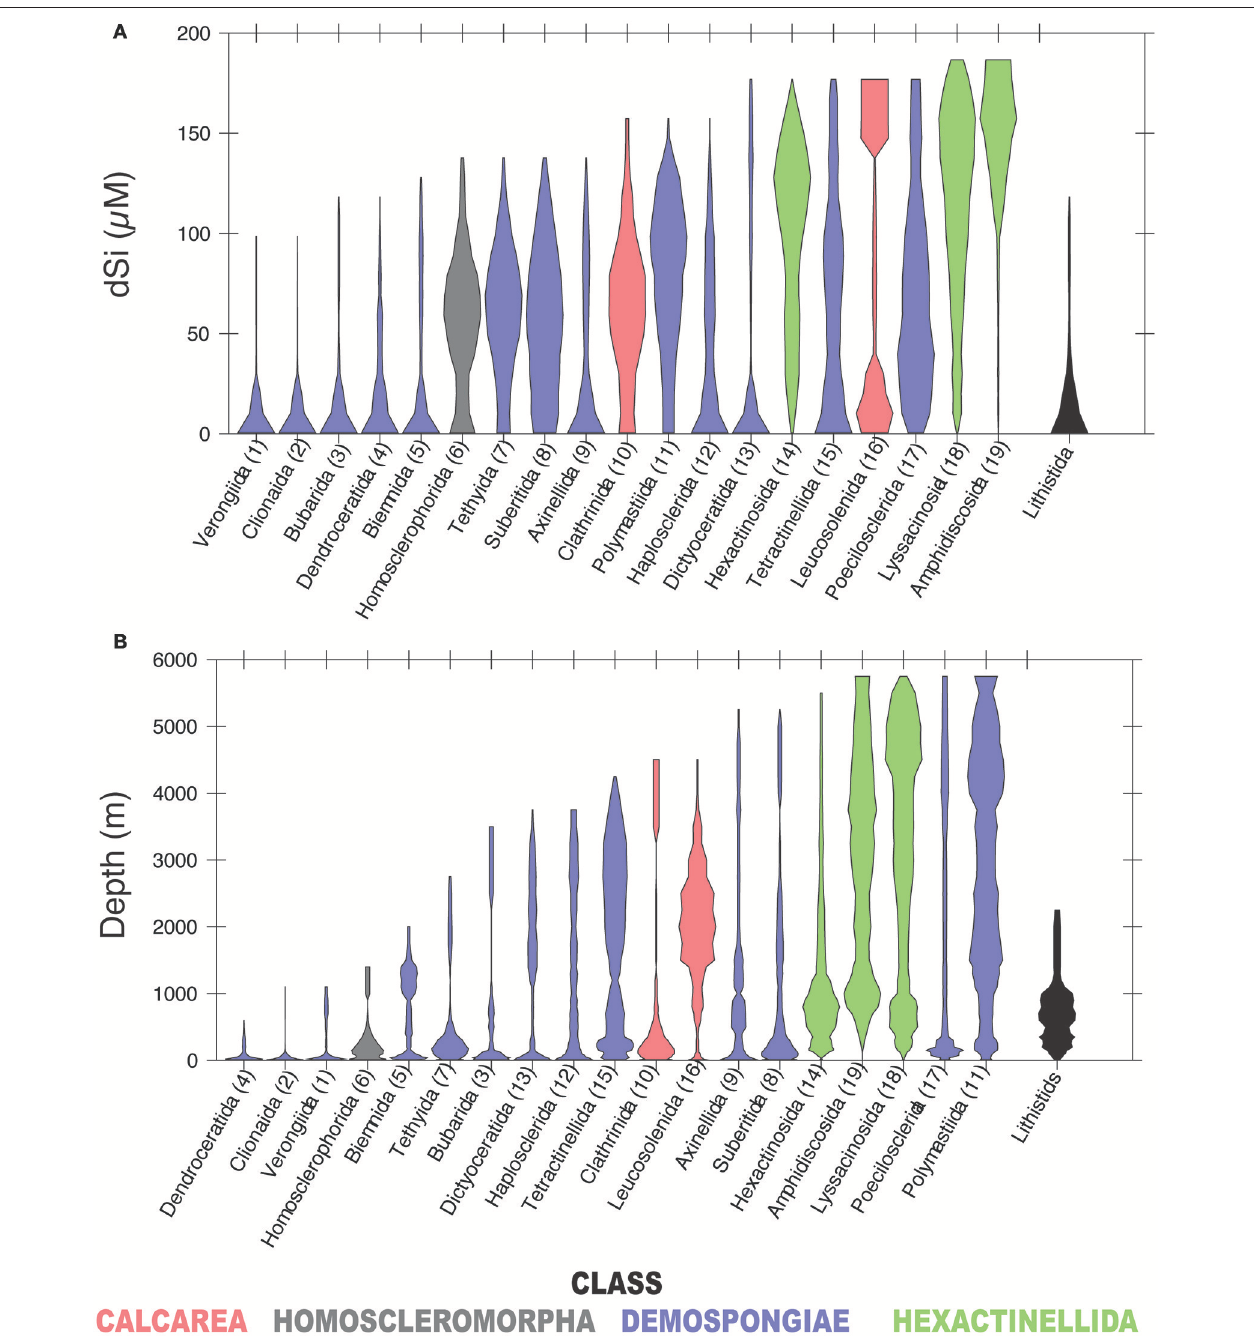
FIGURE 4 | Violin plots showing the distribution of sponge orders along the dSi gradient (A) and the depth gradient (B) . Only orders represented within GBIF in at least 100 boxes of WOCE dataset are shown. Numbers in parenthesis are codes given to each of the represented orders. Lithistids includes taxa assigned to this taxon by Pisera and Lévi (2002). Taxa with gray background include sponges without siliceous spicules. Color codes as in Figure